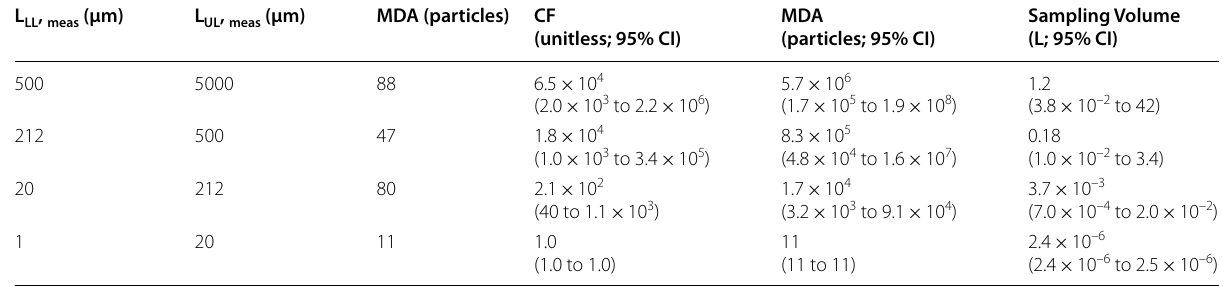
Table 5 Reported and rescaled Minimum Detectable Amounts (MDAs) for MP analysis using Raman or Infrared Spectroscopy reported from DeFrond et al. [27] (95% intervals based on microplastics length distribution power law value in bottled waters from Nizamali J, Mintenig SM, Koelmans AA: Assessing microplastic characteristics in bottled drinking water and air deposition samples using laser direct infrared imaging, in preparation). Desired sampling volumes derived using default mass-aligned screening level without UF’s applied (i.e., 4.6 10 6 ×